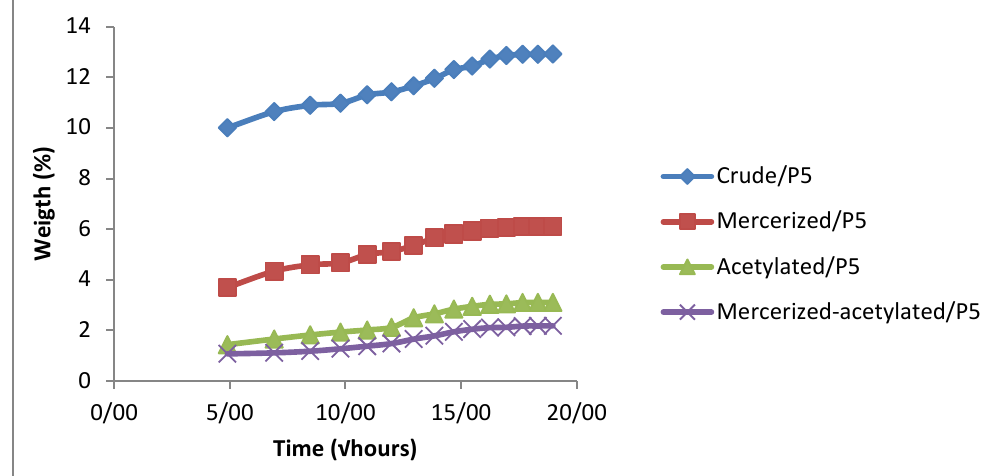
Fig. 5. Moisture absorption behaviour over time for P5 fibre